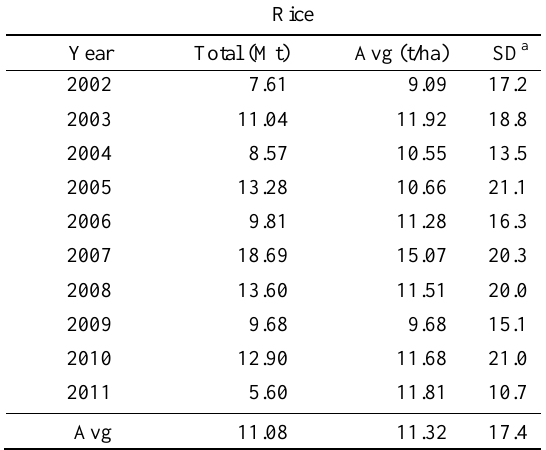
Table 4. Yearly estimation of total fuel load ( in million tonnes or Mt) and its average (t/ha) during rice harvesting season.